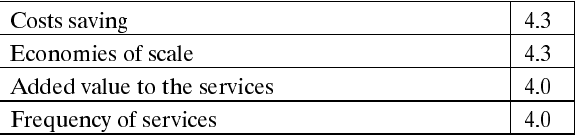
Table 5. Benefit from joint facilitated cooperation with other companies from the same type of business Costs